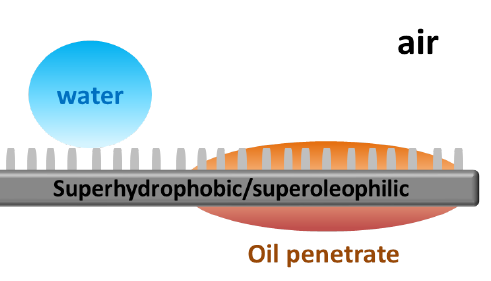
Figure 8. Superhydrophobic mesh for oil–water